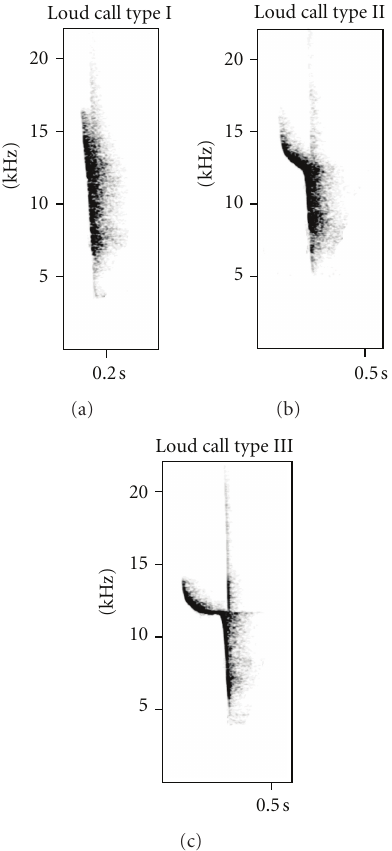
Figure 3: Three types of loud calls classified on the basis of the length of the whistle part (a–c).